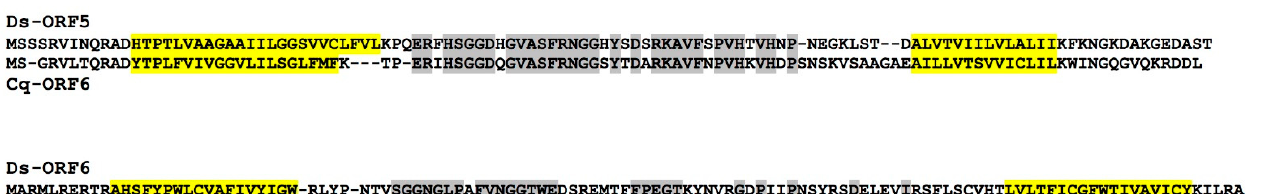
Figure 5. Sequence alignment of small membrane-bound TGB-like proteins encoded by ORF5 and ORF6 in the D. scoparium VLRA with those encoded in ORF6 and ORF7 in C. quitensis VLRA. Hydrophobic segments are in yellow; residues identical in central hydrophilic regions are shaded. Note consensus “SGG(D/N)xxxxxFxNGGxxxDSRxxxFxPxxTxxN” which is common between the central hydrophilic regions of proteins encoded by Ds-ORF5 and 6.